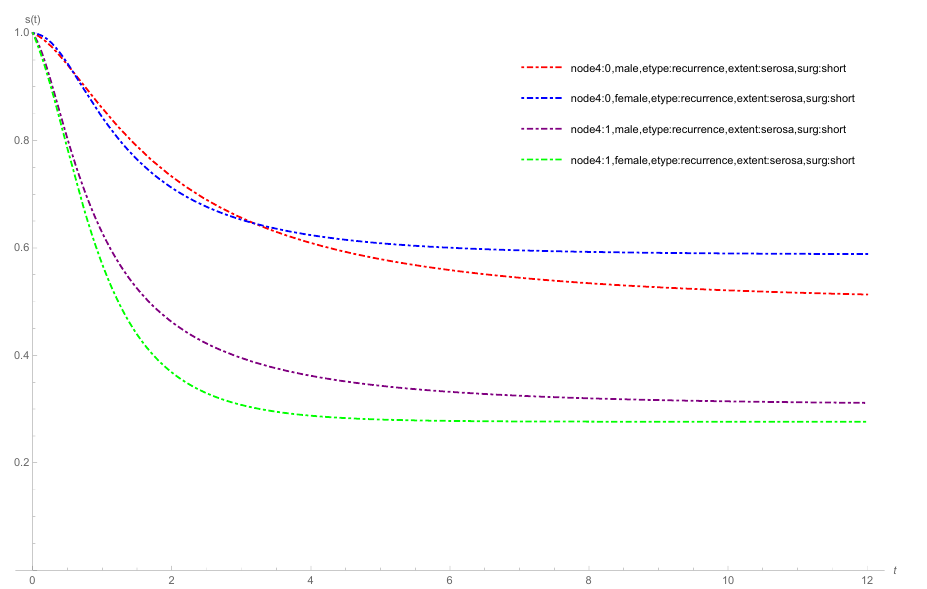
Figure 3. Plots of the survival functions for the colon data based on F-SCR/GeTNH model stratified by sex status for patients with more than 4 positive lymph nodes (0 = no, 1 = yes); event type: recurrence; time from surgery to registration: short; extent of local spread: serosa.